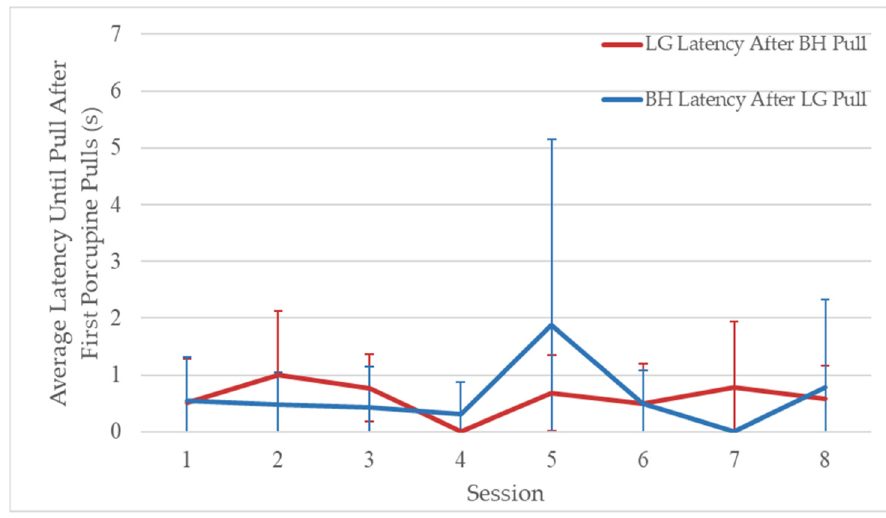
Figure 6. Time until success across sessions in Phase 2. Error bars depict standard deviations.